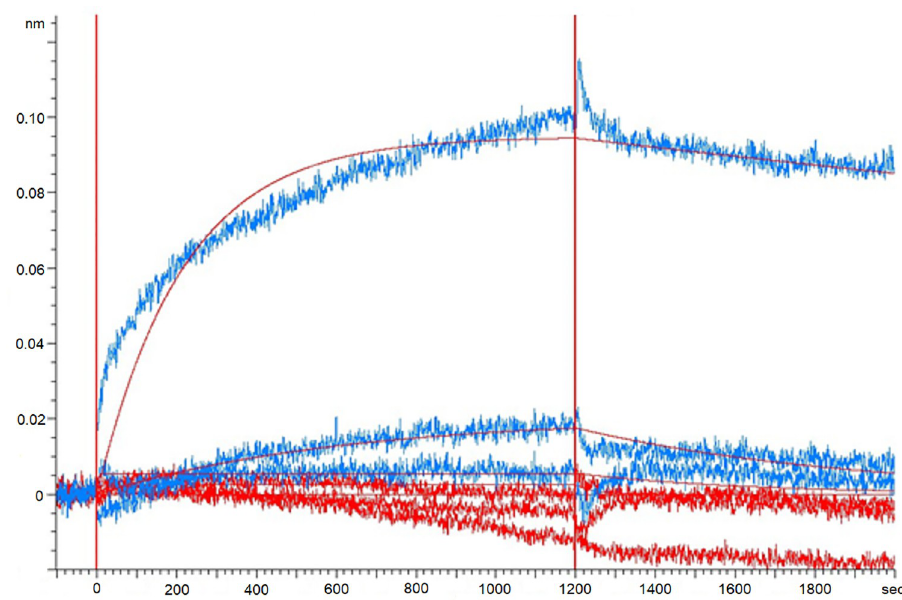
Fig 4. Kinetic measurements of renin and hepcidin-20 and hepcidin-25. Binding properties of different forms of hepcidin was measured with biolayer interferometry using biotinylated renin as ligand with streptavidin sensors and hepcidin-20 and hepcidin-25 as analyte. Binding was measured with different concentrations of analyte (100, 50 and 12.5 μ M) and binding curves of hepcidin-25 and hepcidin-20 are shown with blue and red, respectively. Baseline (-100–0 s), association (0–1200 s) and dissociation (1200–2000 s) are shown.